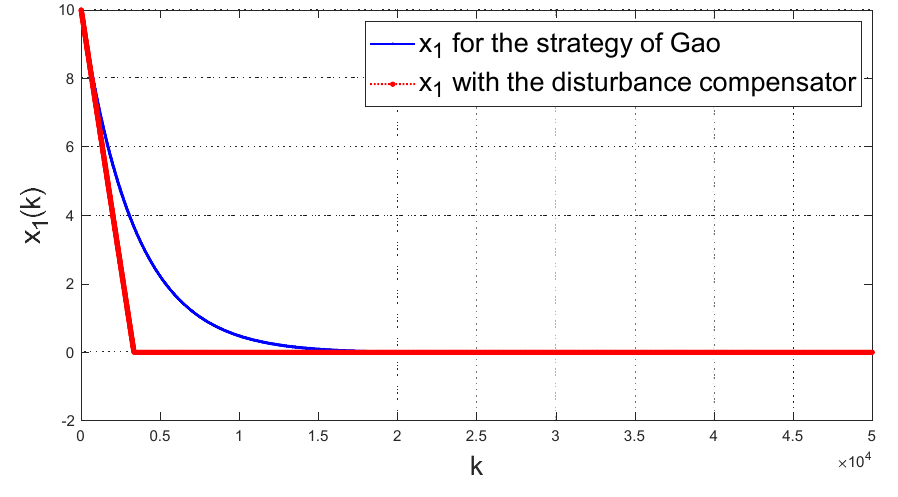
14 of 19 Figure 3. Comparison of the discrete-time sliding variables in the sliding phase. Figure 4. Evolution of the control signal u ( k ). Figure 5. Evolution of the control signal in the sliding phase.